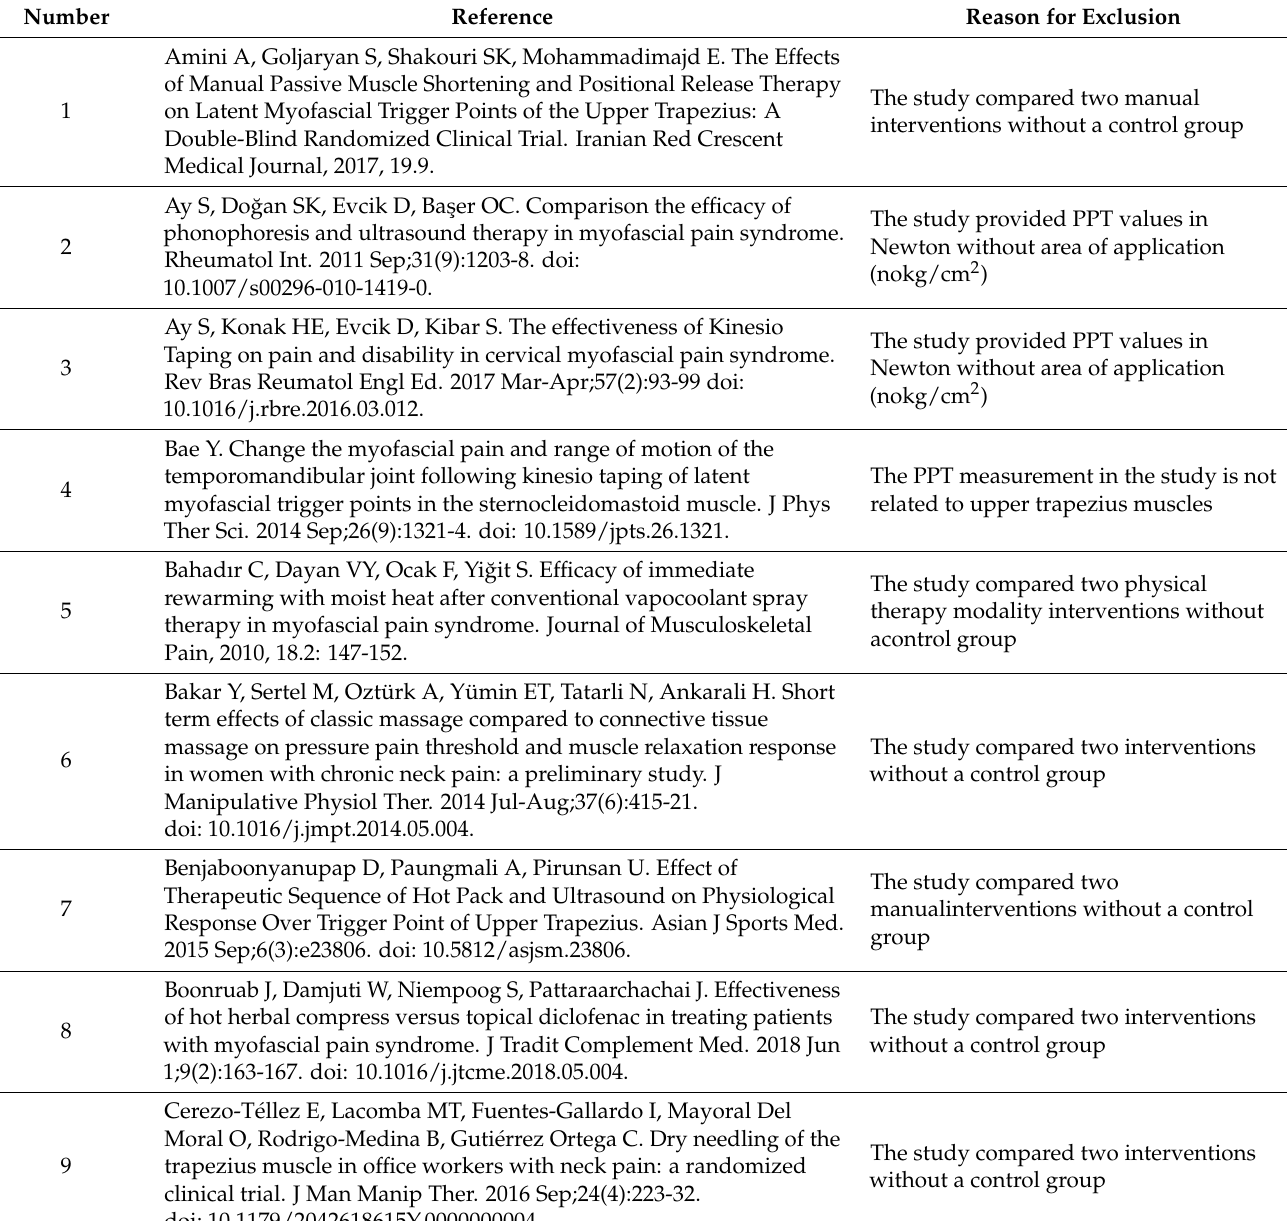
Table A2. List of excluded studies after full text reading with reasons for